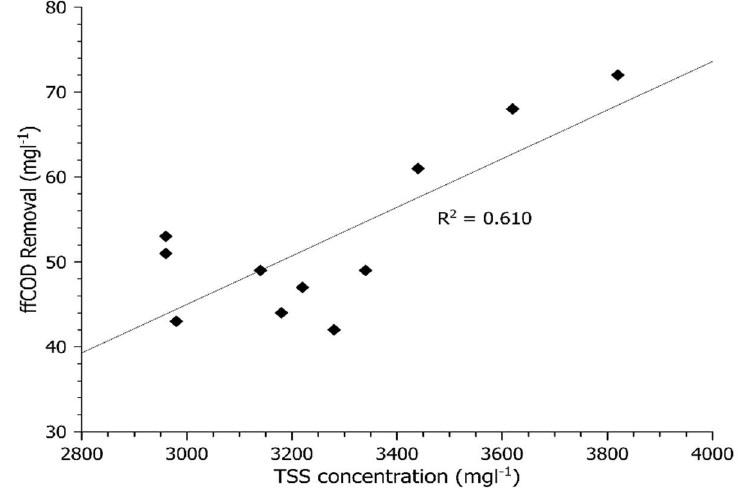
Figure 2. ff COD removal as a function of WAS TSS during 30-min of biosorption.